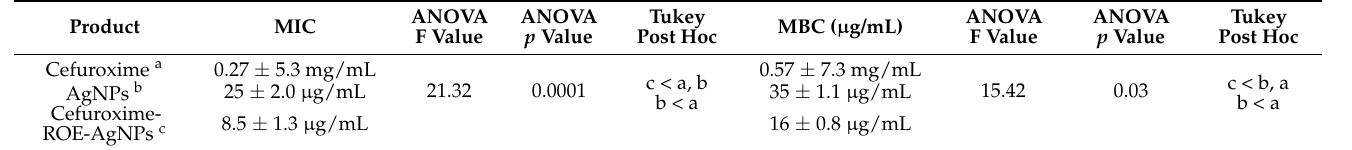
Table 3. Minimum inhibitory concentration of the solutions against S.